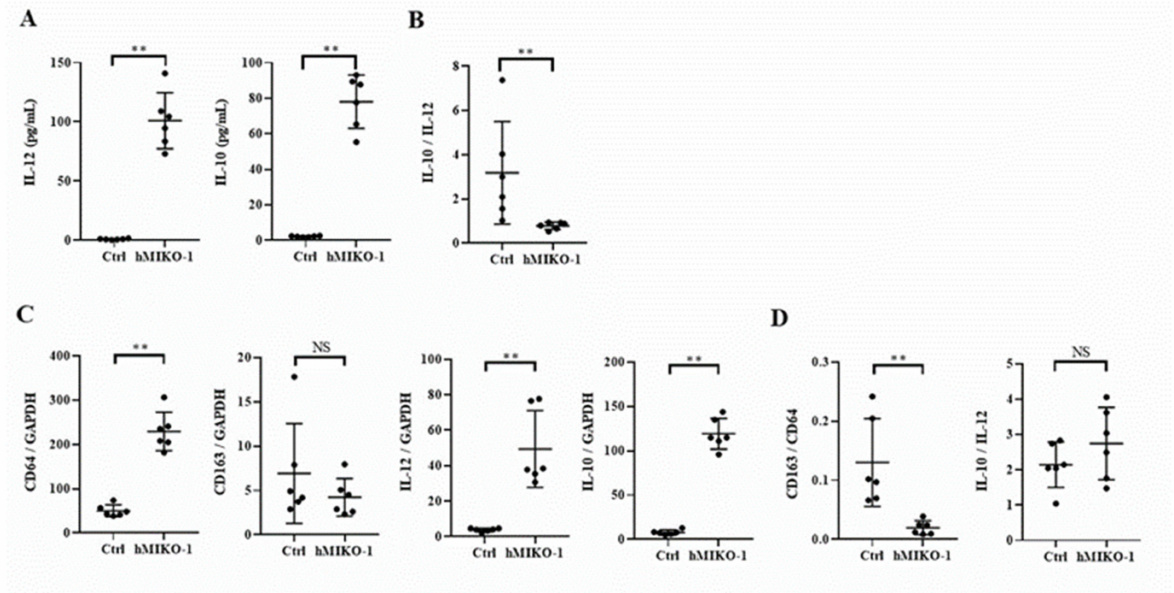
Figure 4. Cytokine concentration in the culture supernatant and gene expression in murine macrophages. Culture supernatant concentrations of IL-12 and IL-10 ( A ) and the IL-10/IL-12 ratio ( B ). Relative mRNA expression of CD64, CD163, IL-12, and IL-10 ( C ) and the CD163/CD64 and IL-10/IL-12 ratios ( D ) in murine macrophages. hMIKO-1: hMIKO-1 co-culture group. Ctrl: Control group in which hMIKO-1 was not added. Data are shown as mean ± SD (N = 6 per group). ** p < 0.01, significant differences between the linked groups. NS: not